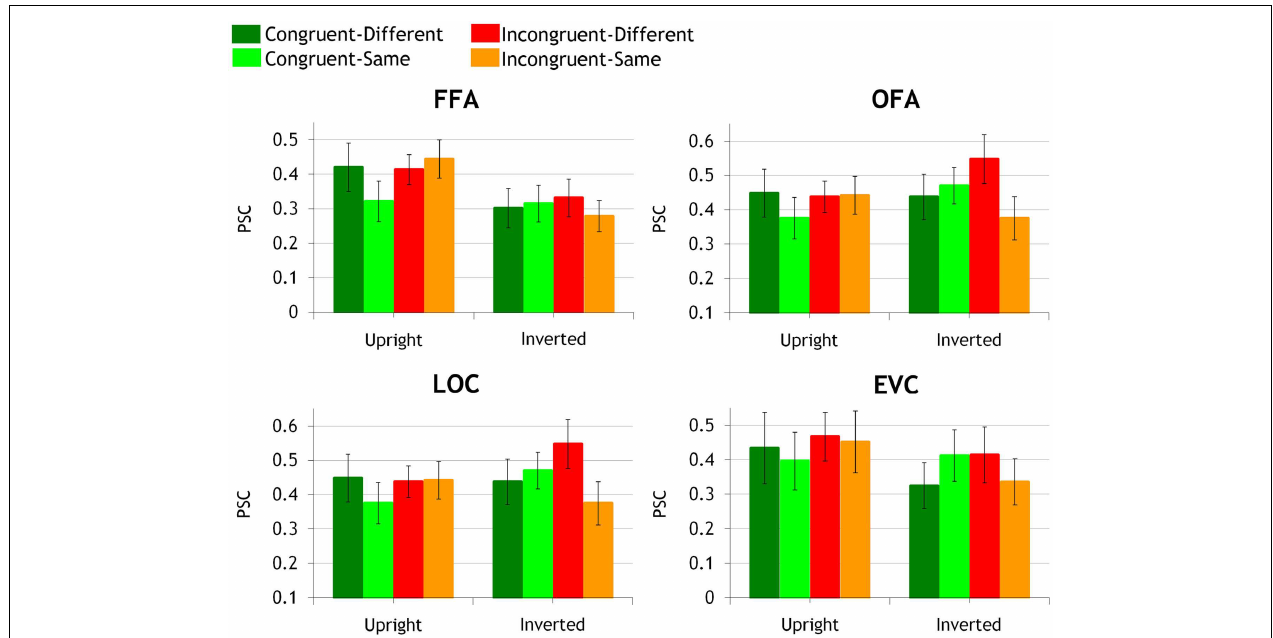
FIGURE 3 |Activation peak grand averages in bilateral FFA, OFA, LOC, and EVC ROIs are shown in congruent-same, congruent-different, incongruent-same, and incongruent-different conditions, at upright and